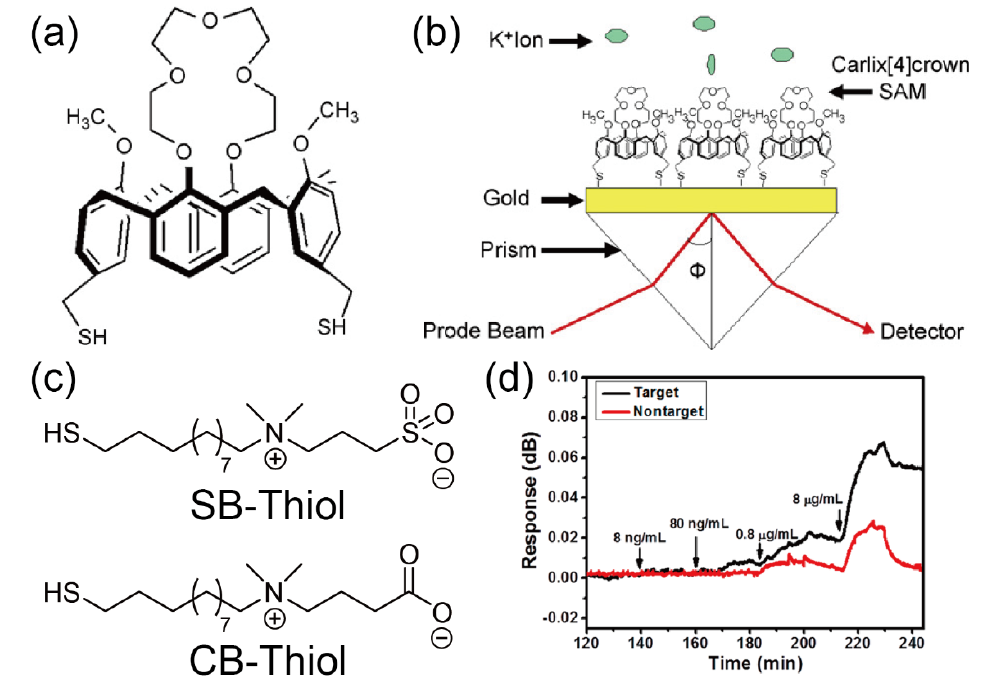
Figure 9. ( a ) Chemical structure of the calix[4]crown derivative for the preparation of SPR sensors. ( b ) Schematic illustration of a calix[4]crown SAM-modified SPR sensor for the detection of K + . Reproduced and adapted with permission from reference [42]. Copyright 2008 Elsevier B. V. ( c ) Molecular structures of the zwitterionic compounds for the construction of the SAM-based protein sensor. ( d ) Changes in the SPR responses of target (rabbit polyclonal IgG) and nontarget (chicken polyclonal IgG) onto the mixed SAM by flowing secondary antibodies (goat anti-rabbit IgG) at various concentrations. Reproduced and adapted with permission from reference [43]. Copyright 2019 American Chemical Society. Surface-enhanced Raman scattering spectroscopy (SERS) methods are also powerful approaches to determine the molecular recognition behavior of receptors at the interfaces with high sensitivity [64]. In SERS-based devices, the molecules captured on the rough surfaces of the metal substrates enhance the intensity of the inelastic scattering of photons (the Raman effect). Thus, the sensing behavior of synthetic receptor assemblies on the devices’ surfaces can be sensitively detected. Hung et al. reported real-time monitoring of drugs in blood plasma by using SERS-based devices functionalized with SAMs for chemical sensing [44]. In addition, the surface of the prepared SERS device was also coated by a zwitterionic poly(carboxybetaine) layer (PCBAA) to reduce the non- specific adsorption of plasma proteins (Figure 10). The drugs selected for this study were a tricyclic antidepressant (amitriptyline hydrochloride; AH) and anti-seizure medications (carbamazepine— CARB and phenytoin—PHEN), respectively. Mixed SAMs consisting of 3-mercaptopropionic acid and 1-propanethiol were utilized for the detection of the drug targets through electrostatic and hydrophobic interactions. As a result, the discrimination of these drugs in blood plasma was successfully demonstrated. More importantly, the prepared SERS sensors functionalized with the mixed SAMs showed high sensitivity in the presence of competing interferences (Table 1). The sensitivity achieved for the selected targets covered the clinically relevant levels of the drugs [65]. These results could be attributed to the effective interfacial design based on the mixed SAMs and the zwitterionic polymer layer [66]. Accordingly, the SERS sensors functionalized by the receptor assemblies are one of the powerful analytical tools for diagnosis applications.